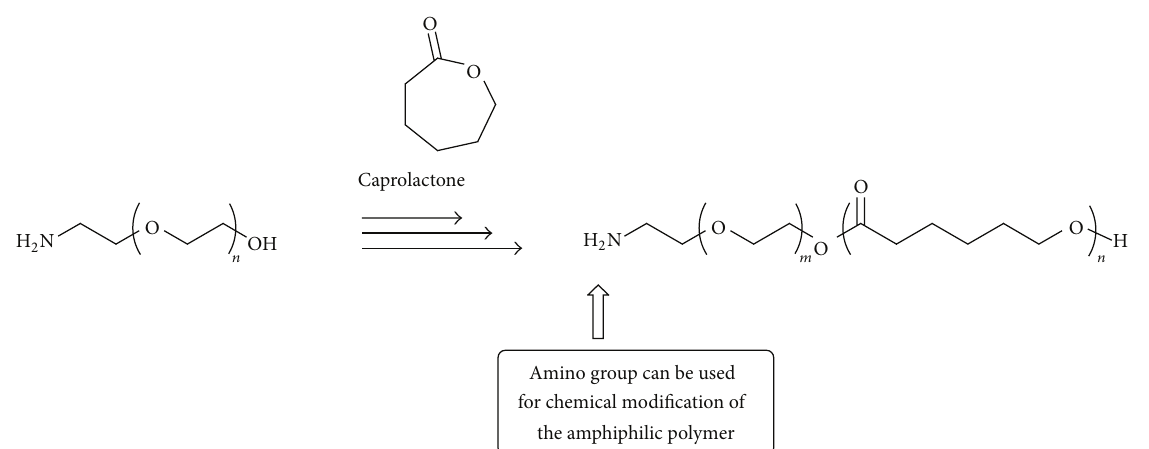
Figure 4: Amphiphilic poly( 𝜀 -caprolactone)- b -poly(ethylene glycol) for micelle